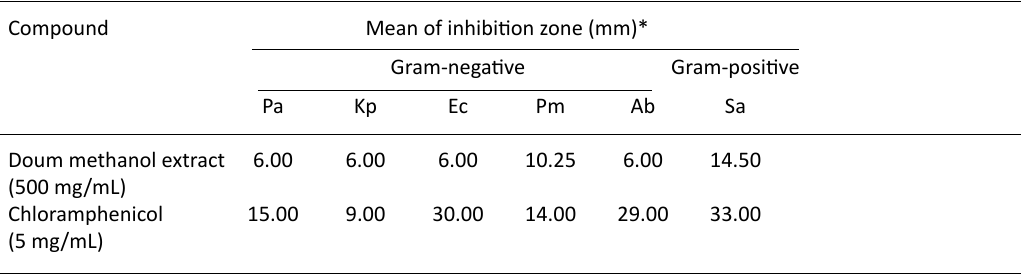
Table 3. The antibacterial potential of the methanolic extract of doum fruit Compound Mean of inhibition zone (mm)* Gram-negative